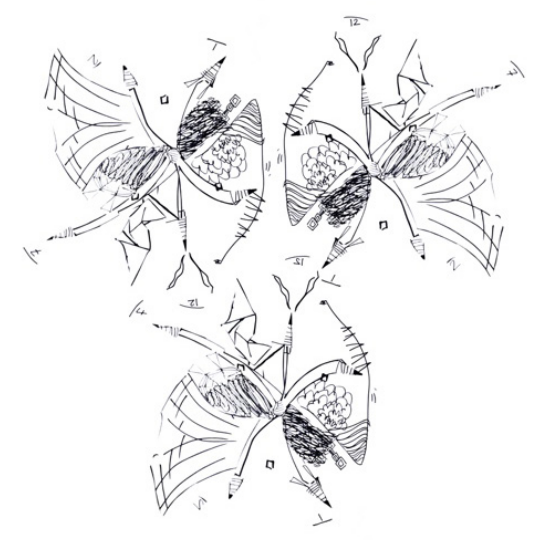
Figure 7. Say Goodbye to the Wind Students gained ability across the range of disciplines which the project involved, including: teamwork, working to deadlines, conversational and written ability in academic fields, conceptual design skills, and practical skills in working with a range of materials to realise designs. That this also resulted in a new confidence in discussing diverse aspects of their collaboration points to benefits accrued in the process of conceptualizing ideas from different knowledge domains and through different practices. If collaborative practice, following Bruffee, is about what he calls ‘conversational proficiency’, our students could be said to have improved their fluency in multiple knowledge domains, opening up an array of conversations to which they were newly empowered to